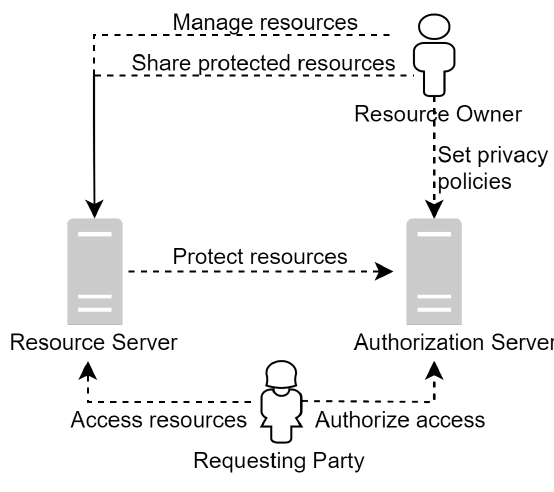
Figure 4. UMA Architecture